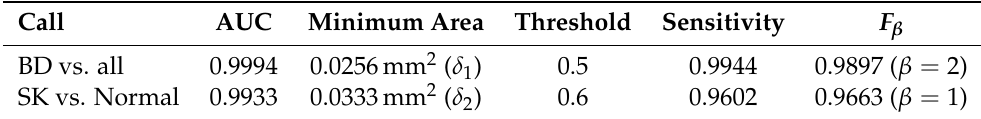
Figure 8. The optimal threshold to call “BD vs. all” or “SK vs. Normal” was computed by line search. The F β score was computed for each candidate threshold on the combined training and validation datasets. For each call, the threshold that yields the highest F β was selected (black dot). Table 3. Selection of the minimal areas and thresholds to call “BD vs. all” and “SK vs. Normal” based on the training